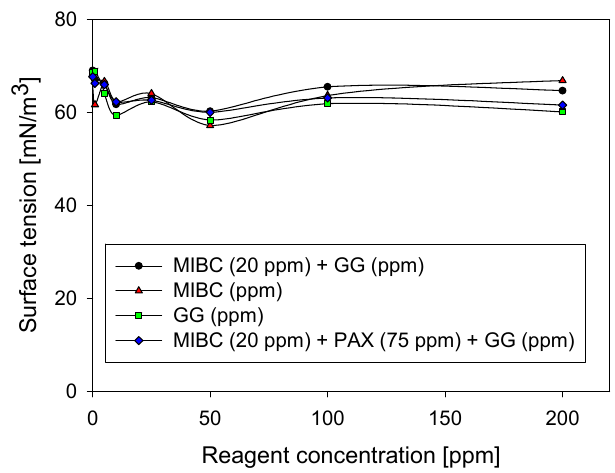
Figure 15. Surface tension as a function of reagents concentrations: (i) varied guar gum (GG) + 20 ppm of MIBC, (ii) varied MIBC, (iii) varied guar gum, and (iv) varied guar gum + 20 ppm of MIBC + 75 ppm of PAX (seawater at pH 8).